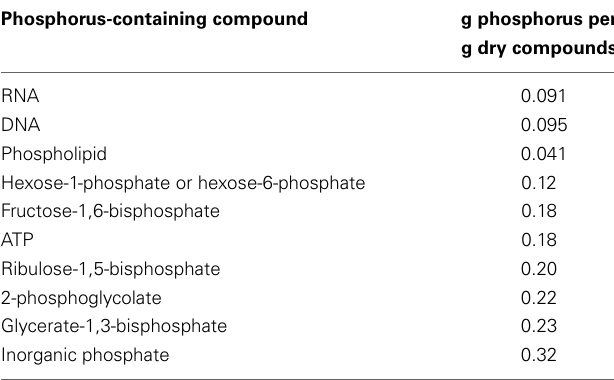
Table 1 | Fraction of phosphorus in phosphorus-containing compounds in